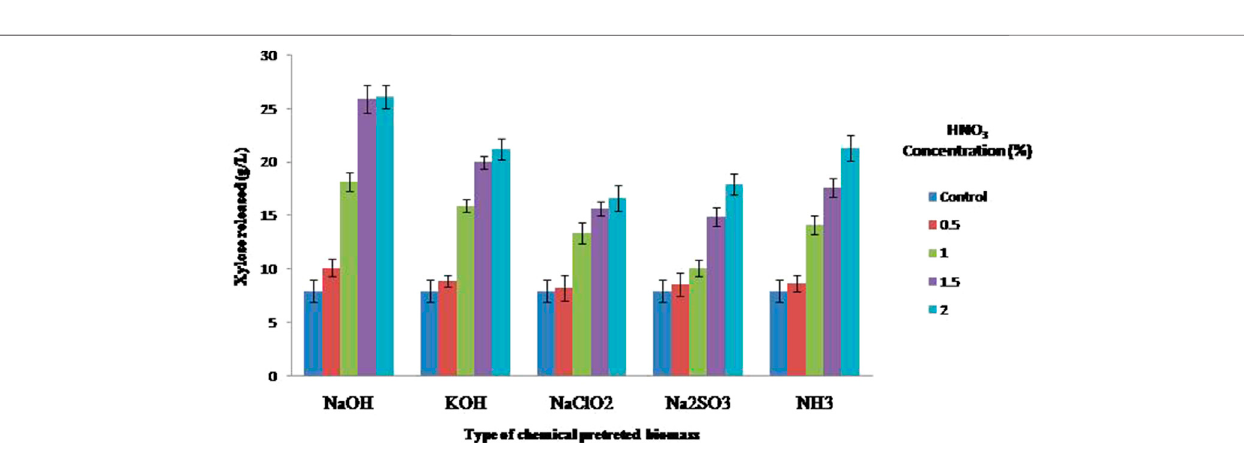
Frontiers in Energy Research |